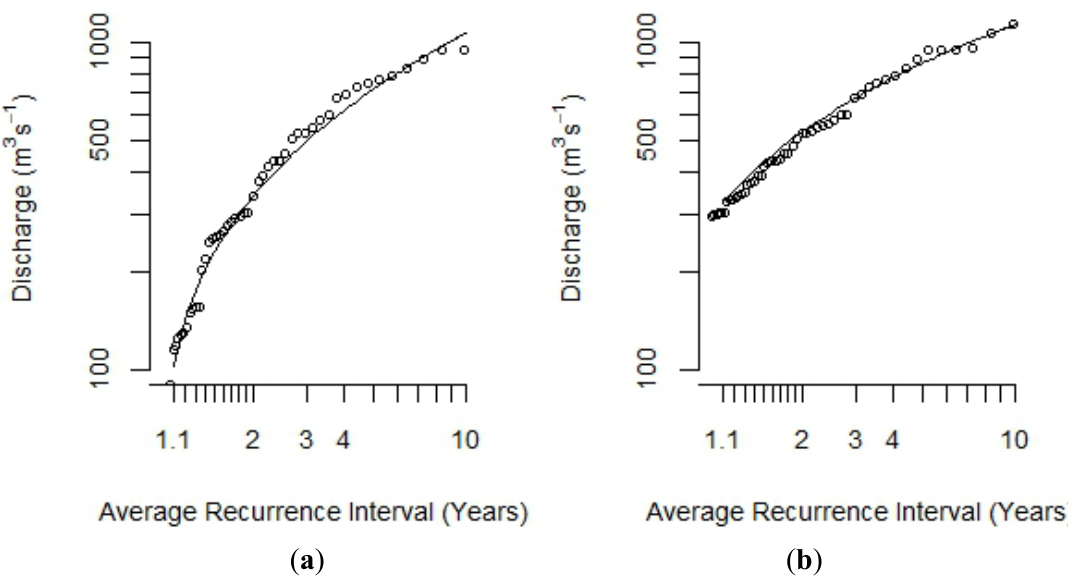
Figure 2. Original stream-flow data compared to fitted probability distributions (solid line) for the South Esk River above Macquarie River (Site 181); ( a ) annual series data against the Log-Normal distribution; and ( b ) partial series data against the Generalised Pareto